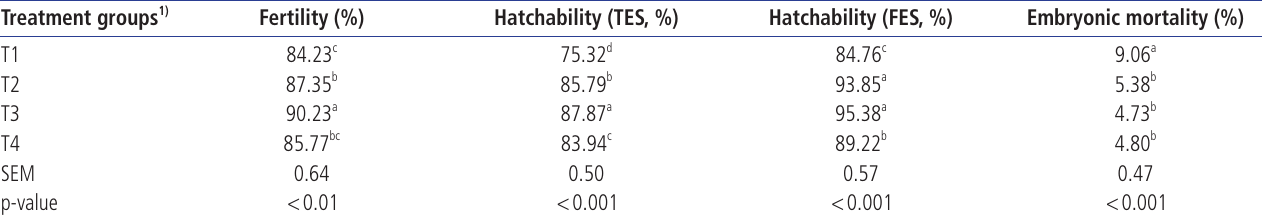
Table 6. Effect of soapnut shell powder supplementation on fertility, hatchability and embryonic mortality among different dietary treatment groups Treatment groups